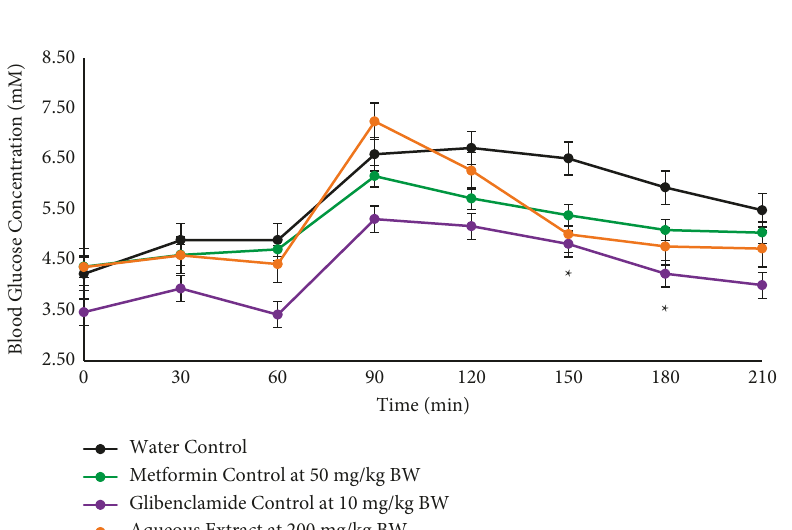
Figure 2: OGTTof the aqueous crude extract from Salvia serotina L. when administered orally at 200mg/kg BW versus water control and oral hypoglycaemic agents glibenclamide and metformin positive controls. n � 6 rats. ∗ − p � 0 . 004 at 150min and ∗ − p � 0 . 015 at 180min.